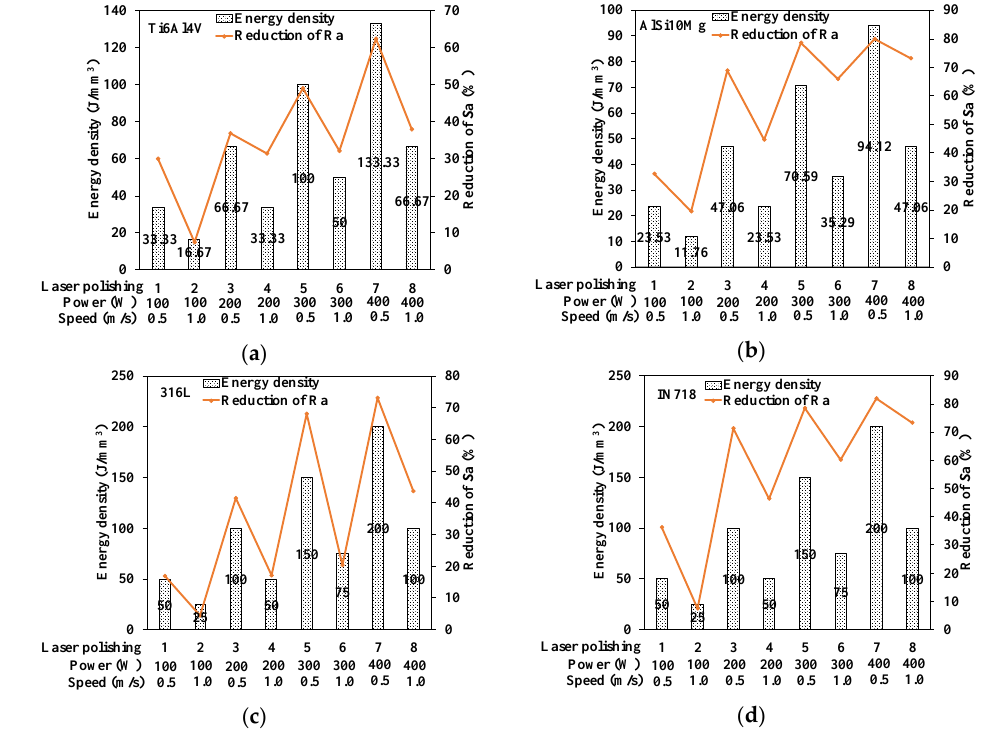
Figure 10. Relationship between energy density and roughness reduction rate: ( a ) Ti6Al4V, ( b ) AlSi10Mg, ( c ) 316L and ( d ) IN718.